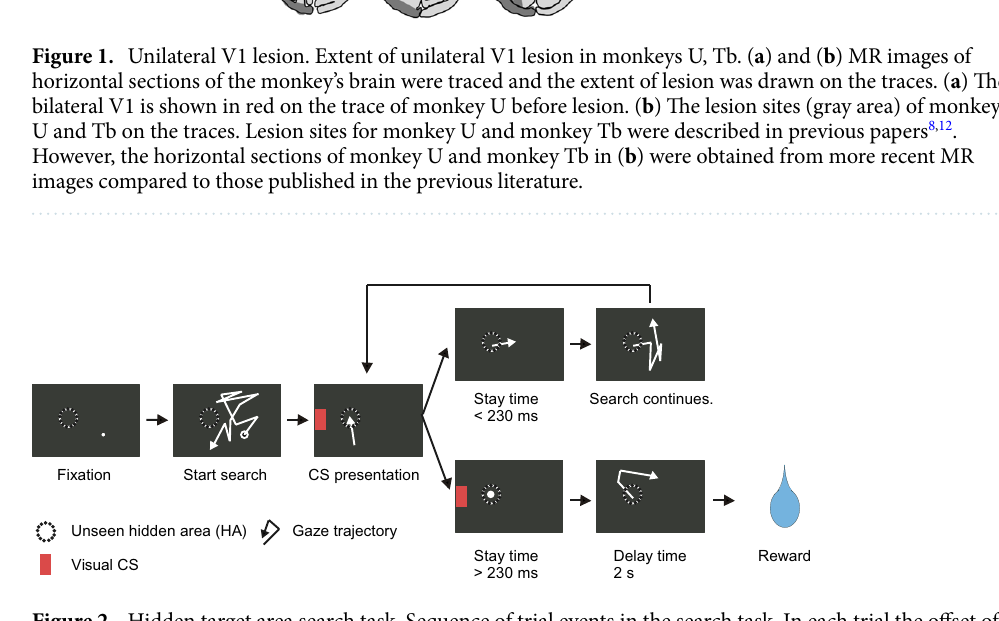
Figure 2. Hidden target area search task. Sequence of trial events in the search task. In each trial the offset of randomly located fixation point signaled that the search for the unseen hidden area (HA) could begin. When the monkey’s gaze entered the HA, a reinforcing visual CS was